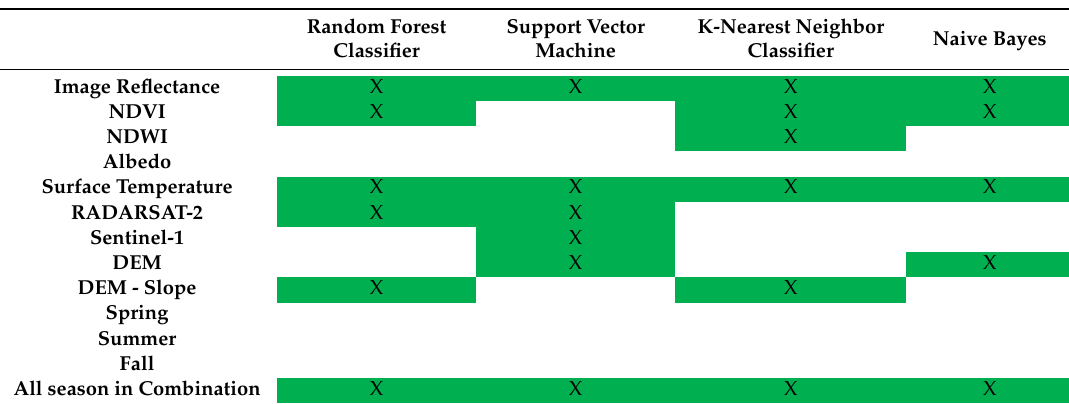
Table 6. Summary of best overall performing input features for individual classification methodologies.